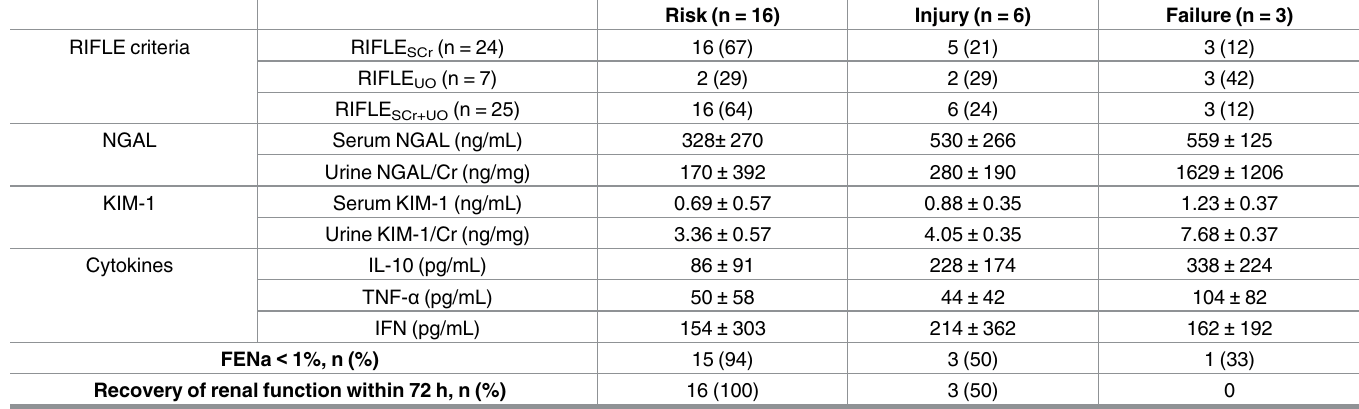
Table 3. Clinical characteristics of 25 patients with